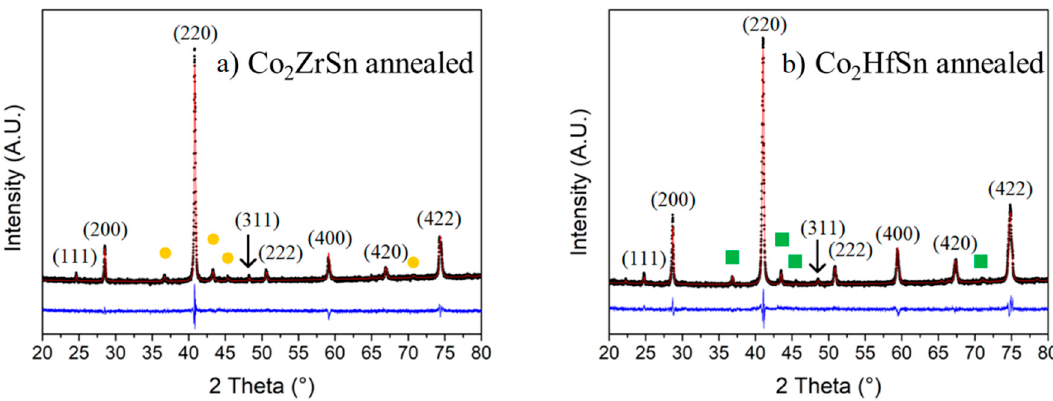
Figure 1. XRD patterns and Rietveld refinements of the Co 2 ZrSn ( a ) and Co 2 HfSn ( b ) annealed alloys. The black symbols and the red continuous line are the experimental and the calculated patterns respectively, while the blue line represents the difference between the two. The peaks proper of the full-Heusler phases are marked with their relative Miller indexes, whereas the signals of the secondary phases are highlighted with colored shapes (orange circles for Co 2 Zr and green squares for Co 2 Hf).